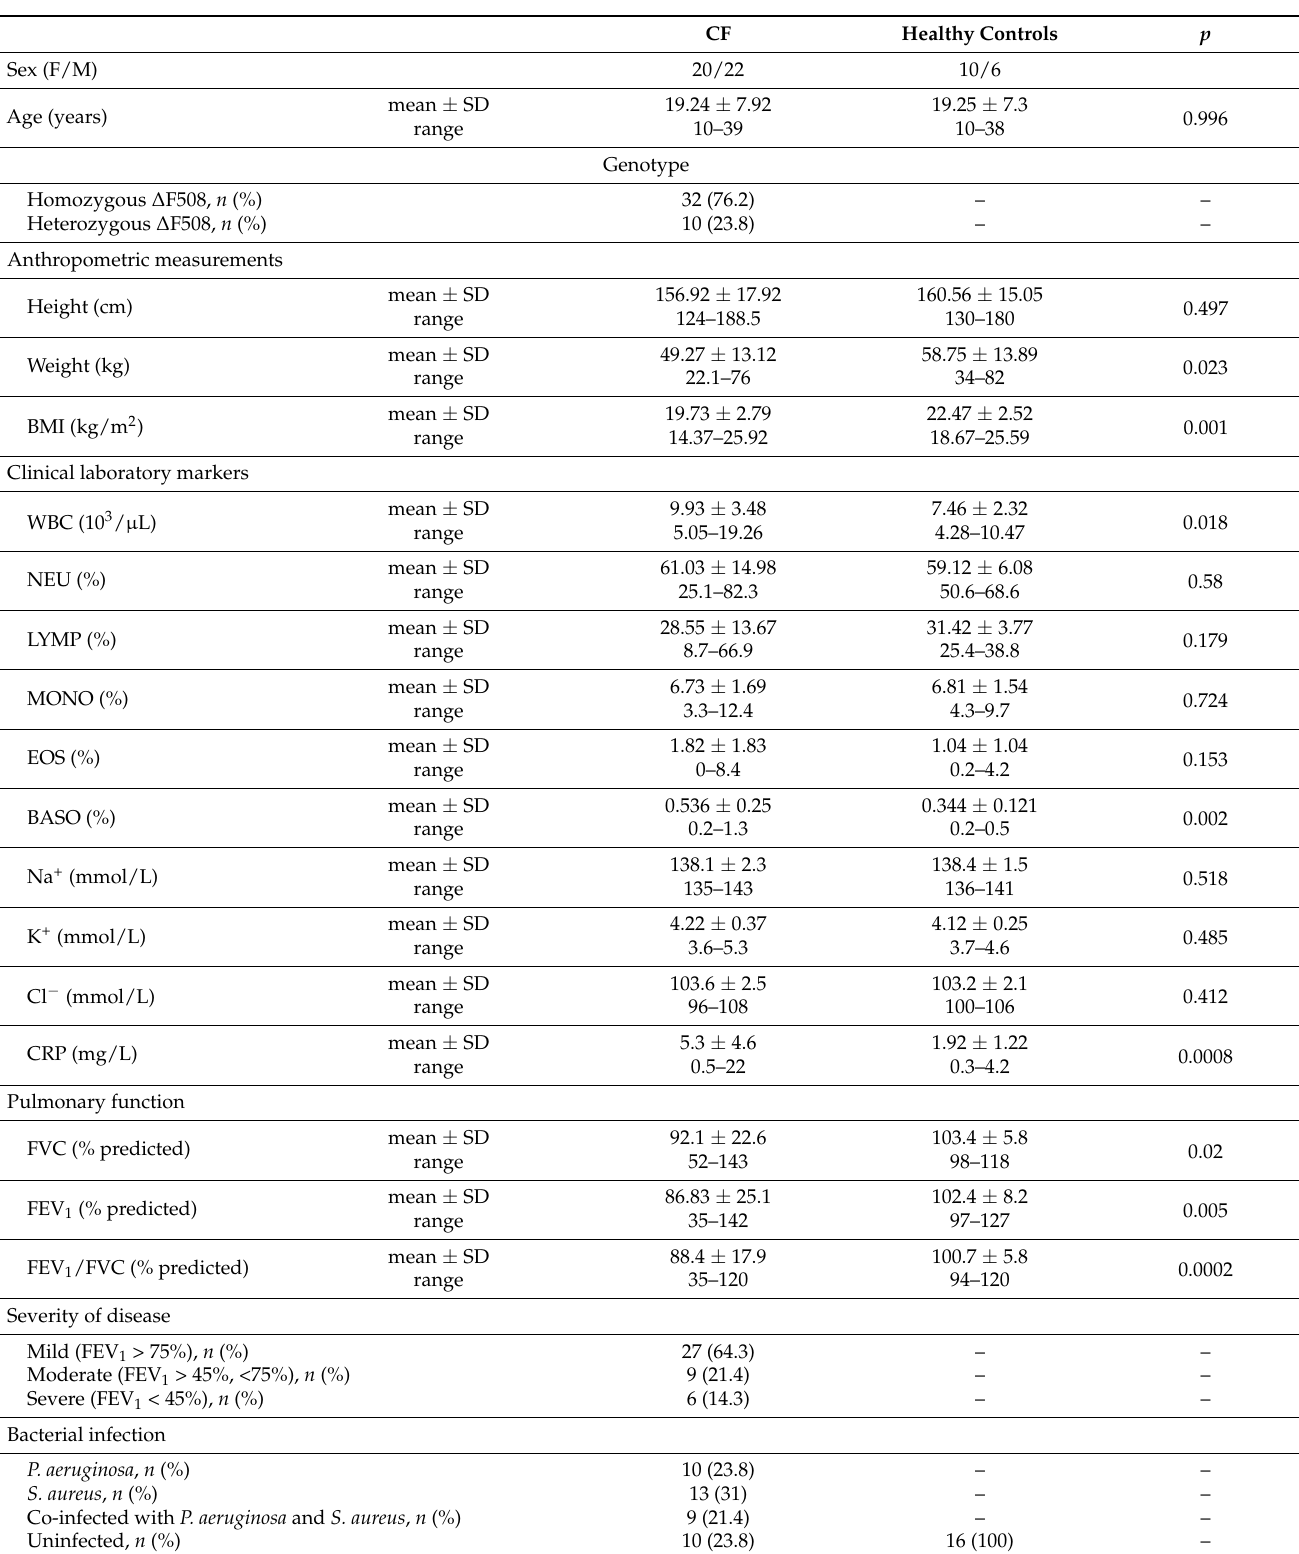
Table 1. Participant demographics at enrollment a